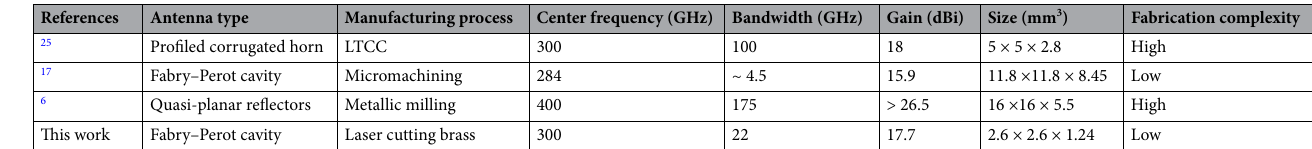
Table 2. Key factor comparison of measurement of this work and other published